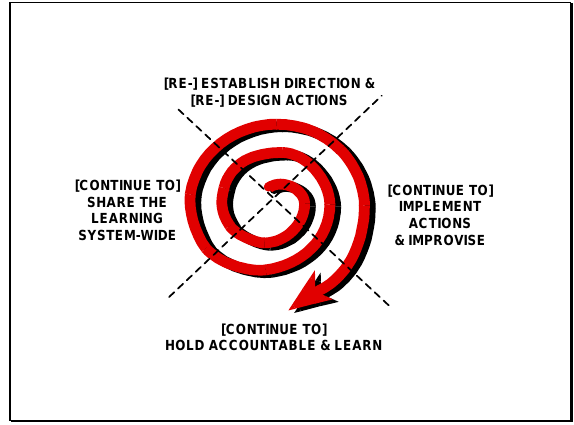
Figure 1: The Guided Changing